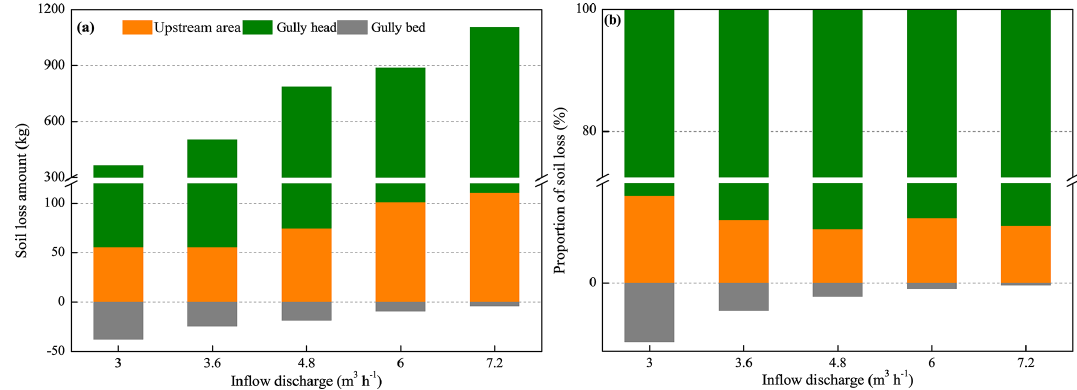
Figure 11. Variation in soil loss amount (a) and proportion (b) of upstream area, gully head, and gully bed with inflow discharge.